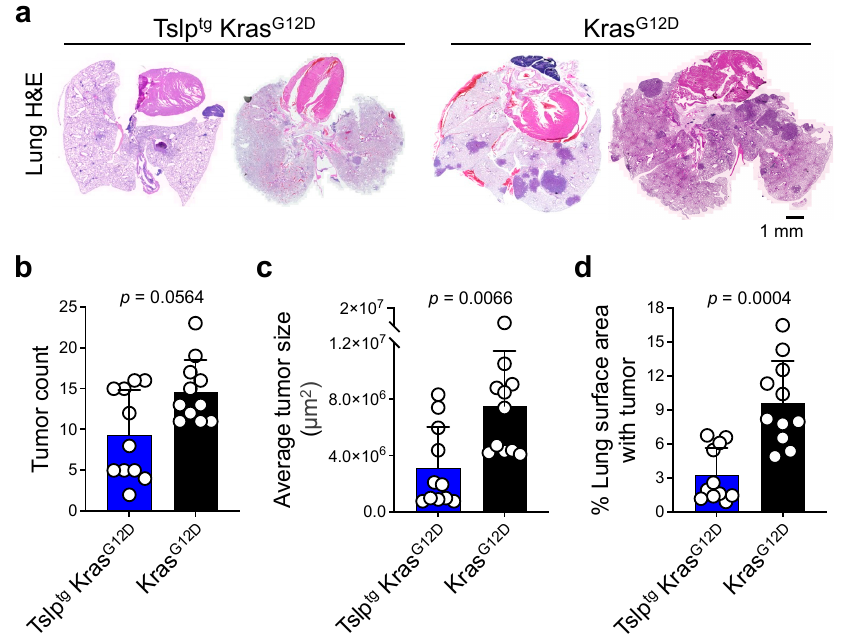
Figure 1. TSLP induction reduces the tumor burden in Kras G12D lungs. ( a ) Representative images of H&E-stained lung of Tslp tg Kras G12D and Kras G12D mice (scale bar: 1 mm). ( b ) Number of tumors in Tslp tg Kras G12D ( n = 11) and Kras G12D ( n = 11) lungs. ( c ) Average size of tumors in Tslp tg Kras G12D ( n = 11) and Kras G12D ( n = 11) lungs. ( d ) Percentage of the lung surface area with tumor in Tslp tg Kras G12D ( n = 11) and Kras G12D ( n = 11) mice. Bar graphs show mean + SD, Mann Whitney U